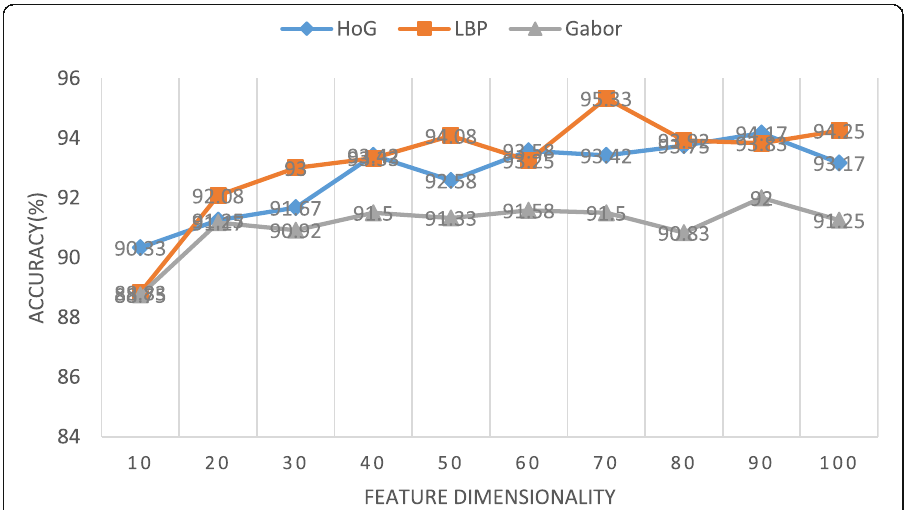
Fig. 8 Accuracy of person-independent facial expression recognition according to feature